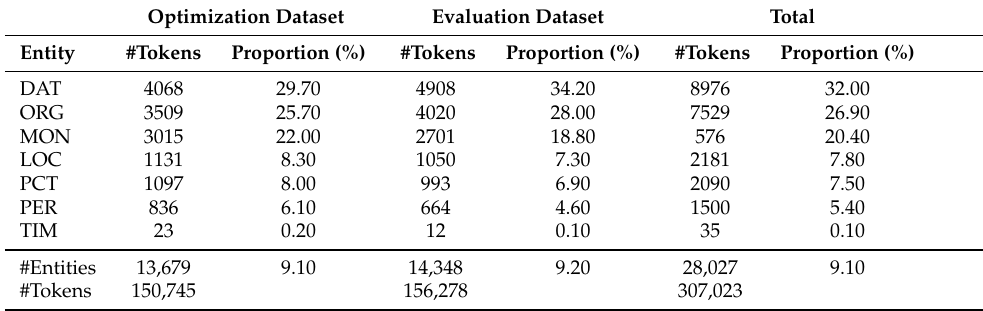
Table 1. Number of tokens belonging to each of the seven entities labelled and the associated proportion relative to the total number of entities detected, for the Optimization and Evaluation datasets that were manually annotated. The last row indicates the total number of tokens belonging to any of the seven entities considered (‘#Entities’) as well as the proportion of the annotated tokens (independent of entity class) relative to the total number of tokens in the dataset (‘#Tokens’). Optimization